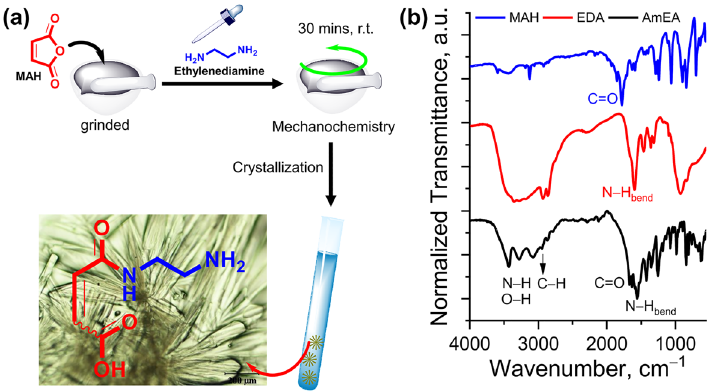
Figure 1. ( a ) Scheme synthesis and photograph of AmEA compound (created by using ChemDraw Professional version 20.0.0.41, https:// www. cambr idges oft. com/ Ensem ble_ for_ Chemi stry/ ChemO ffice/ ChemO ffice Profe ssion al). ( b ) FTIR spectra of MAH, EDA and AmEA